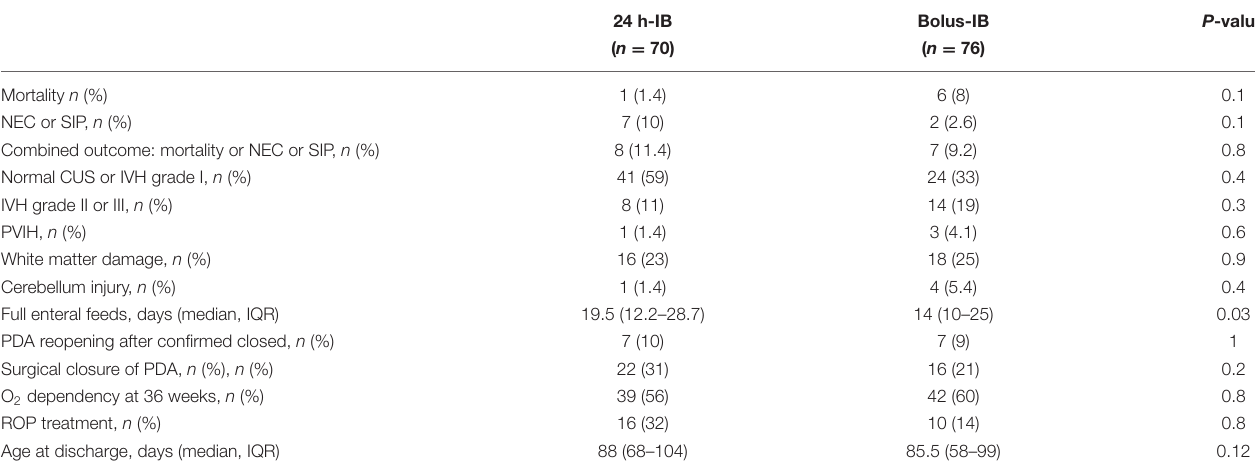
TABLE 3 | Main neonatal diagnosis at term equivalent age.